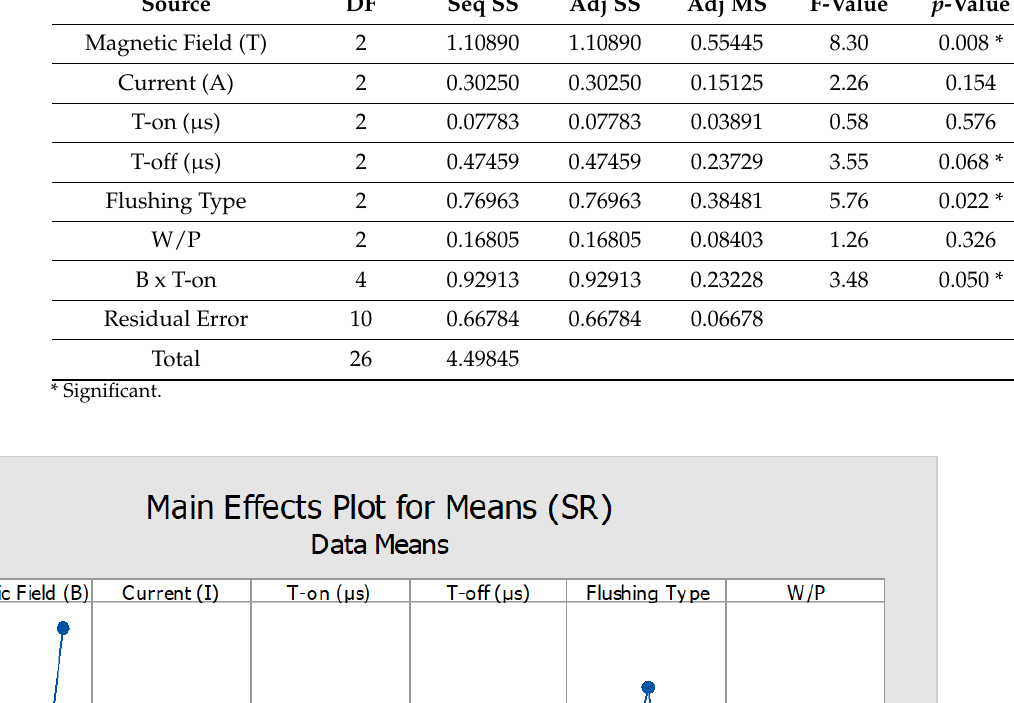
Table 6. ANalysisof VAriance (ANOVA) for Surface Roughness (SR).